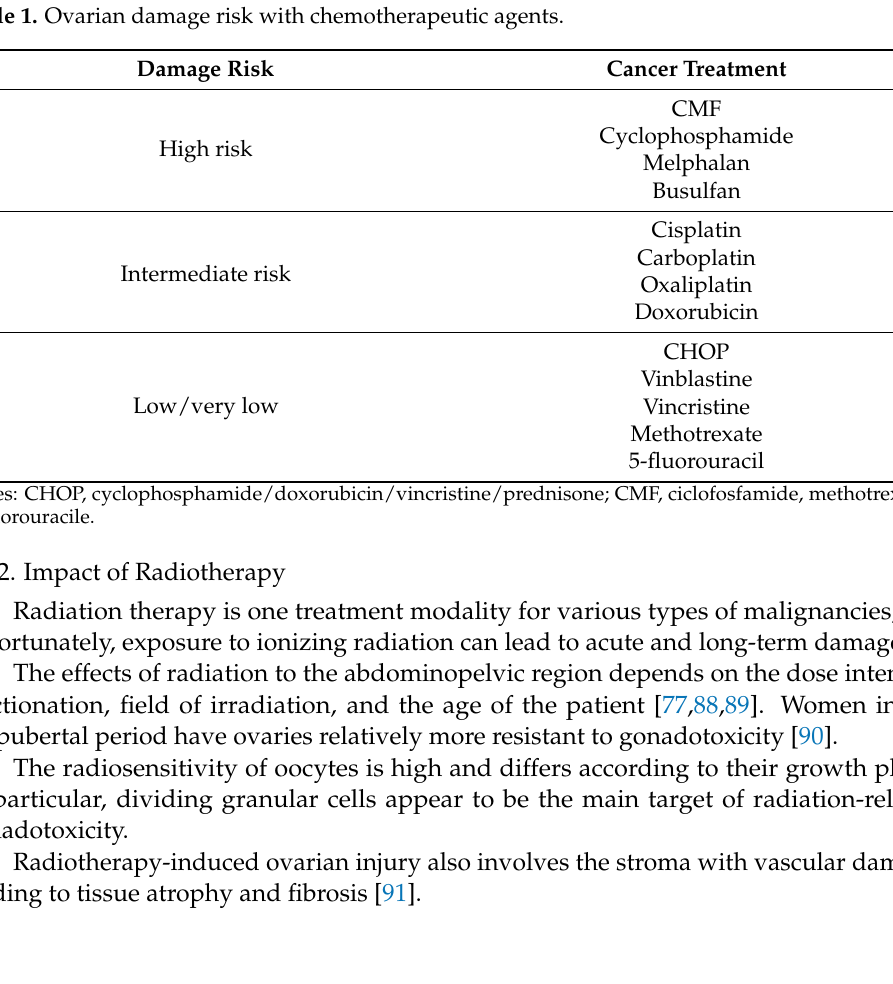
CMF Cyclophosphamide Melphalan Busulfan Cisplatin